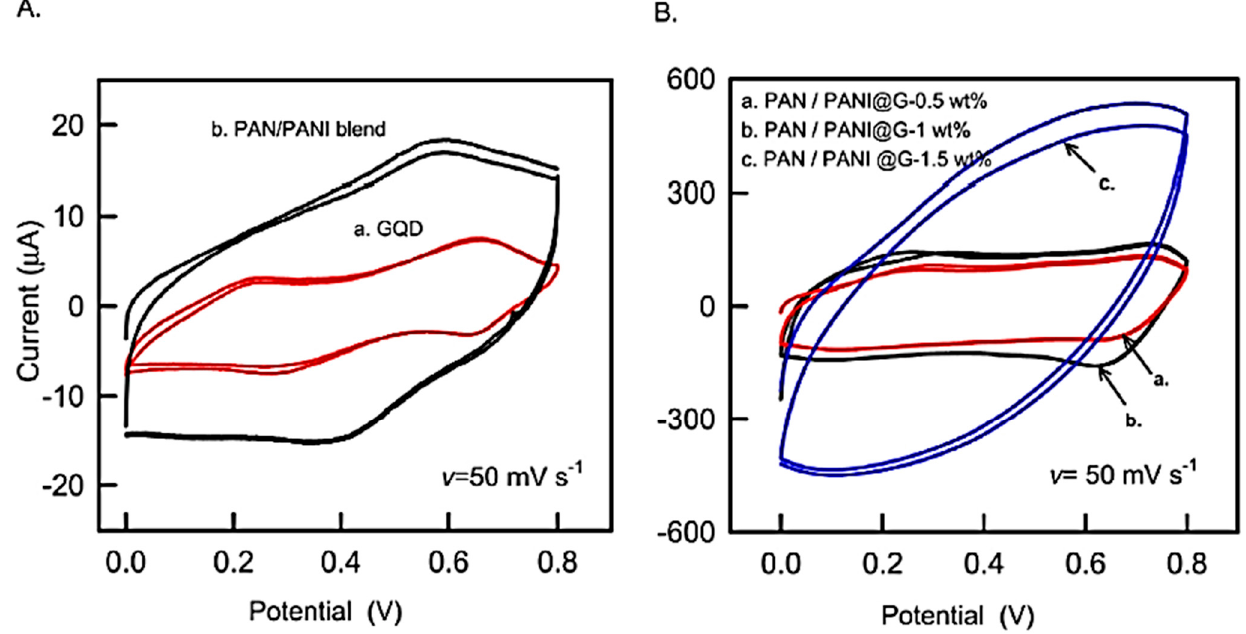
Figure 12. ( A ) CV response of a. GQD, b. PAN-PANI blend and ( B ) CV response of